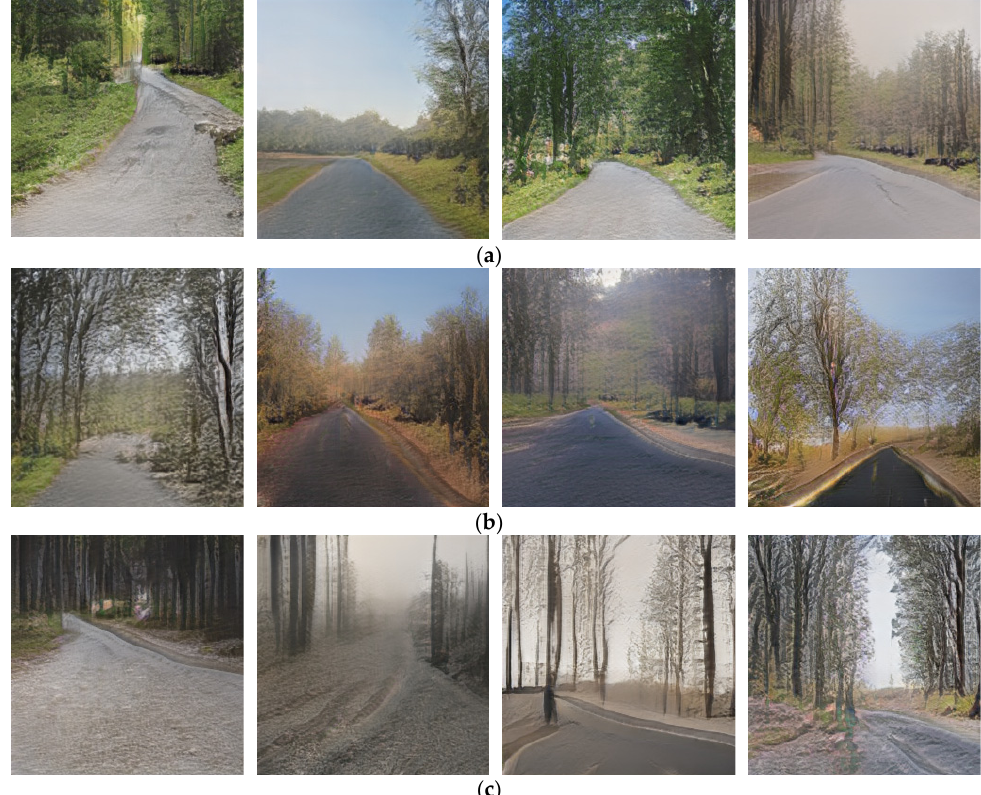
Figure 7. Different Types of Road Images Generated by the Proposed Method. ( a ) “forest road in the morning”, ( b ) “forest road in autumn”, ( c ) “forest road in winter”.